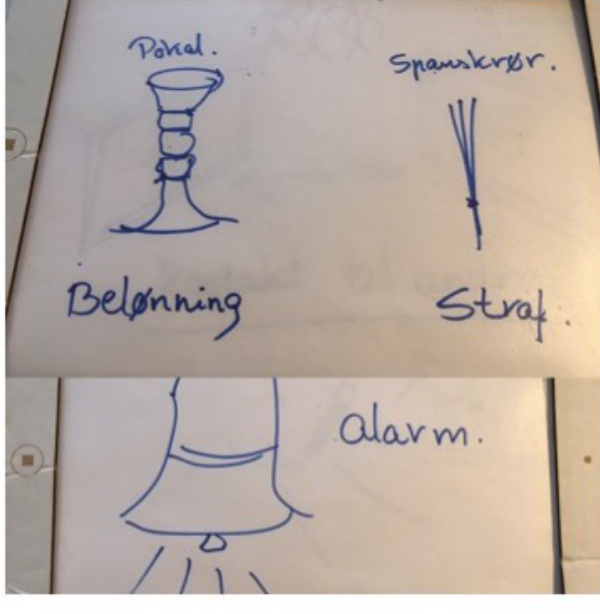
Step 3: From codes to